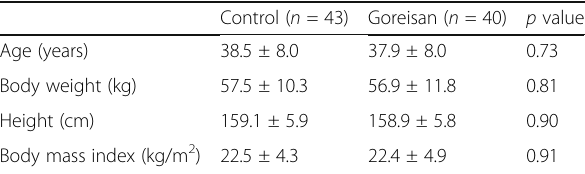
Table 1 Patient demographics